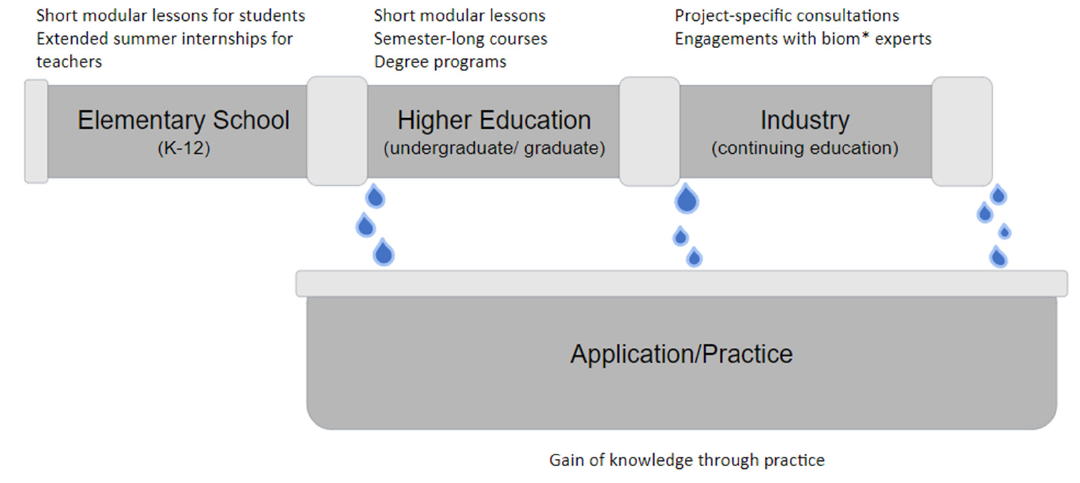
Figure 1. The biom* education pipeline.